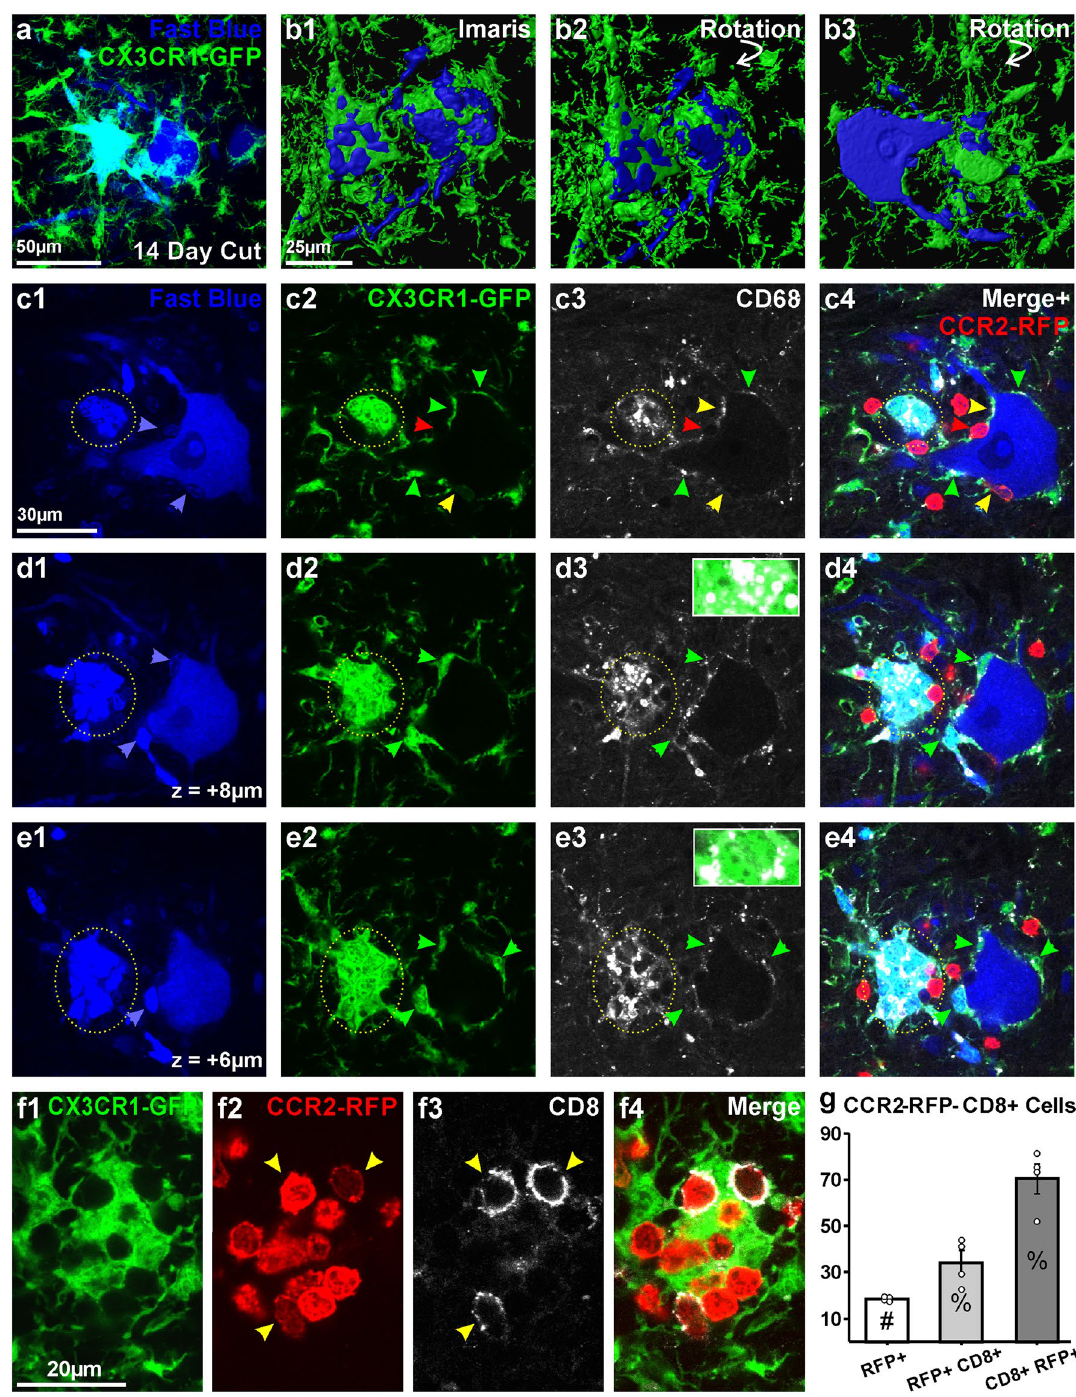
Figure 8. Macroclusters of microglia and CD8 cytotoxic T-lymphocytes surrounding degenerating motoneurons. ( a ) Confocal image through two Fast Blue motoneurons with different microglia coverage 14 days after axotomy. The left motoneuron is fully covered by CX3CR1-GFP microglia; the one in the right is only partially covered. ( b ) Same cells surface rendered in Imaris. ( b1) top surface of both cells; ( b2) partial rotations; ( b3) 180° rotation showing mid cross-sectional planes of these cells. The motoneuron in the left (right in b3 after 180° rotation) has a blebbed cytoplasm and is degenerating. The motoneuron in the right (left after 180° rotation) shows normal cell body and dendrites. ( c1–4;d1–4;e1–4 ) Single confocal optical planes of both motoneurons ( c1,d1,e1 ), CX3CR1-GFP microglia ( c2,d2,e2 ), CD68 ( c3,d3,e3 ) and three colors superimposed with addition of CCR2-RFP cells ( c4,d4,e4 ). Z values in d1 and e1 are respectively the increased section depth from c to d and then from d to e. The dotted circle indicates the microglia macrocluster. Microglia are tightly anastomosed to each other within the macrocluster and fully cover the degenerating motoneuron. Microglia inside the macrocluster highly express CD68 ( e3,d3,e3 ). Microglia attached to